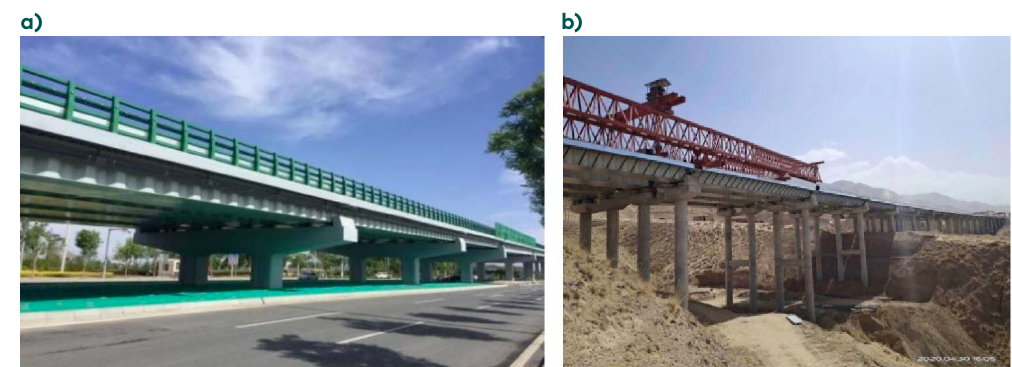
Figure 1. CW-SBS composite box girder at Gansu Province in China: (a) Terminal 2 connecting line continuous beam bridge at Zhongchuan Airport, (b) the construction of Dunhuang to Dangjin mountain Expressway bridge